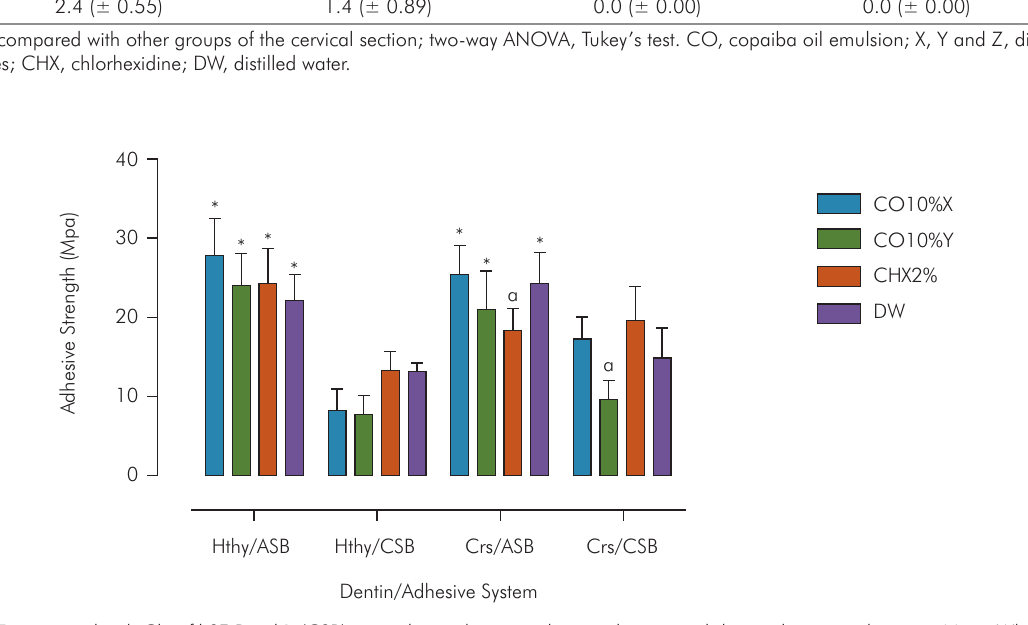
Table 4. Tracer penetration at the composite/tooth interface in the different groups. Groups